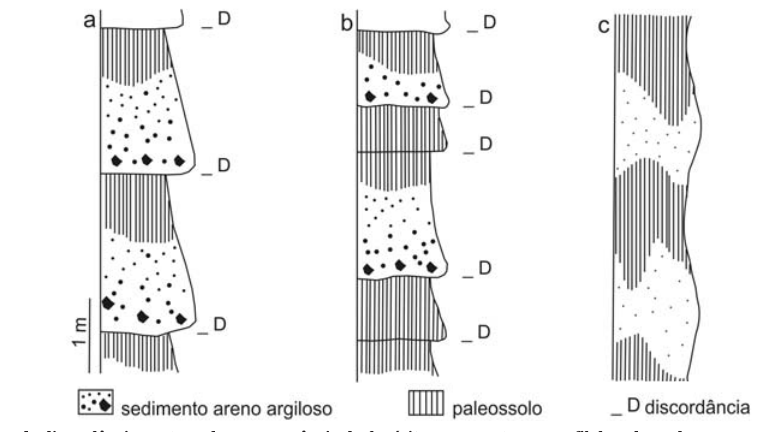
Figura 11. Ciclotema sedimento-pedogenético. Fonte: Meyer